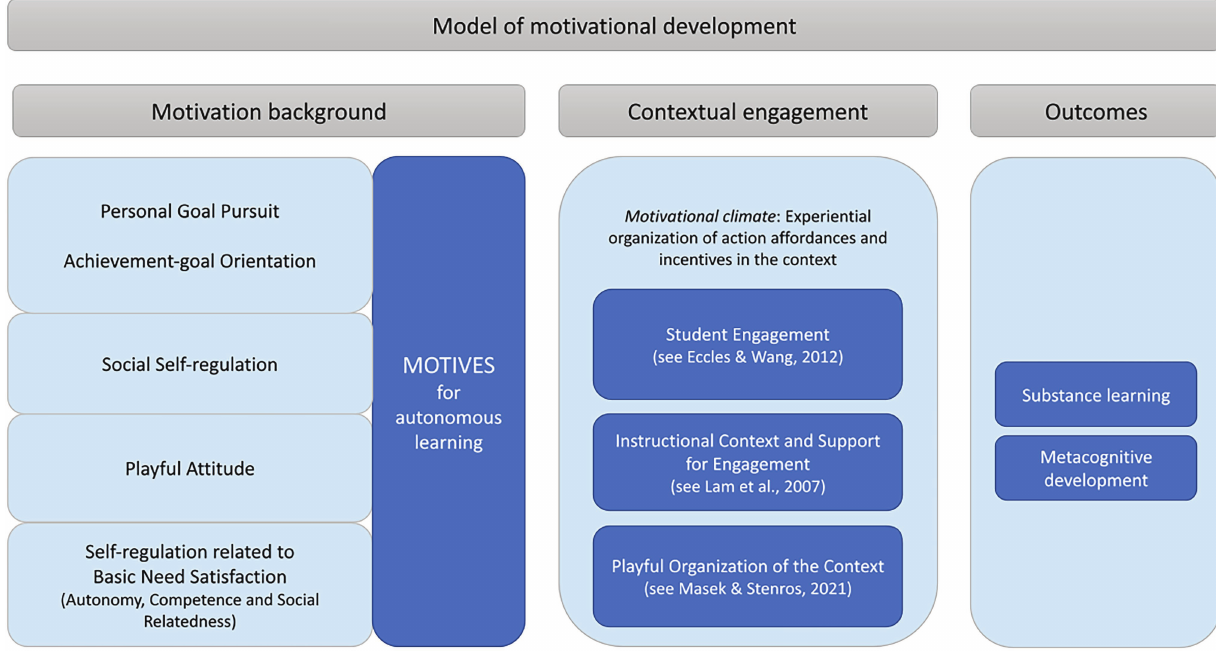
FIGURE 1 | The model of motivational development consisting of three domains (motivation background, contextual engagement, learning outcomes) and their